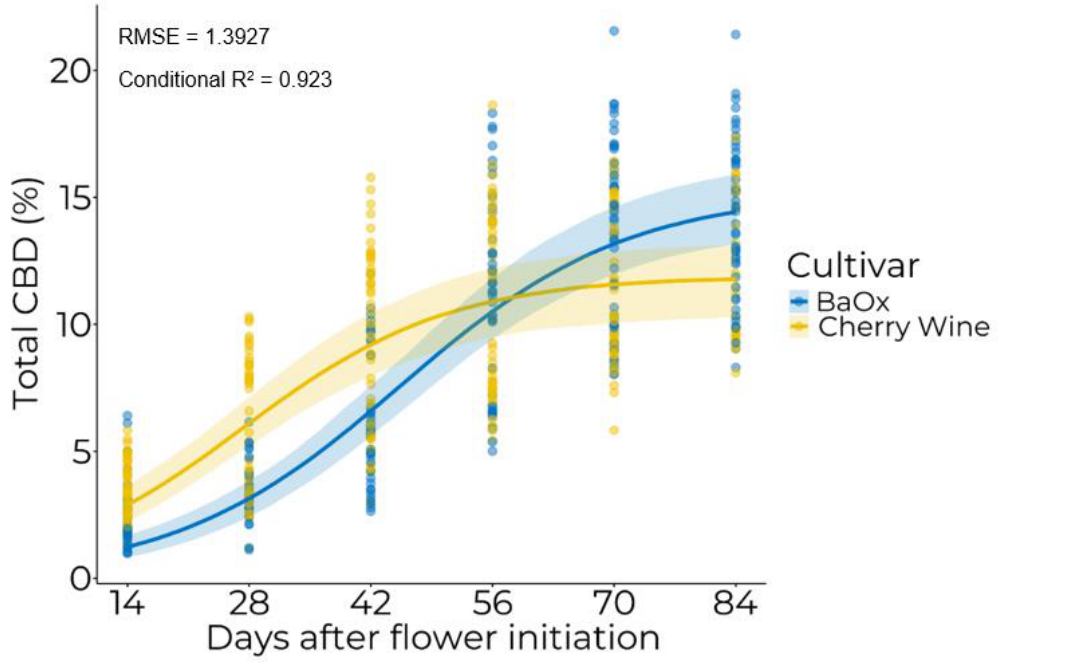
Figure 3. Nonlinear logistic regression for floral hemp total CBD concentration over time as affected by cultivar. Shaded area represents 95% confidence interval for the predicted model. Circles represent plot-level data points. RMSE = Root Mean Square Error.